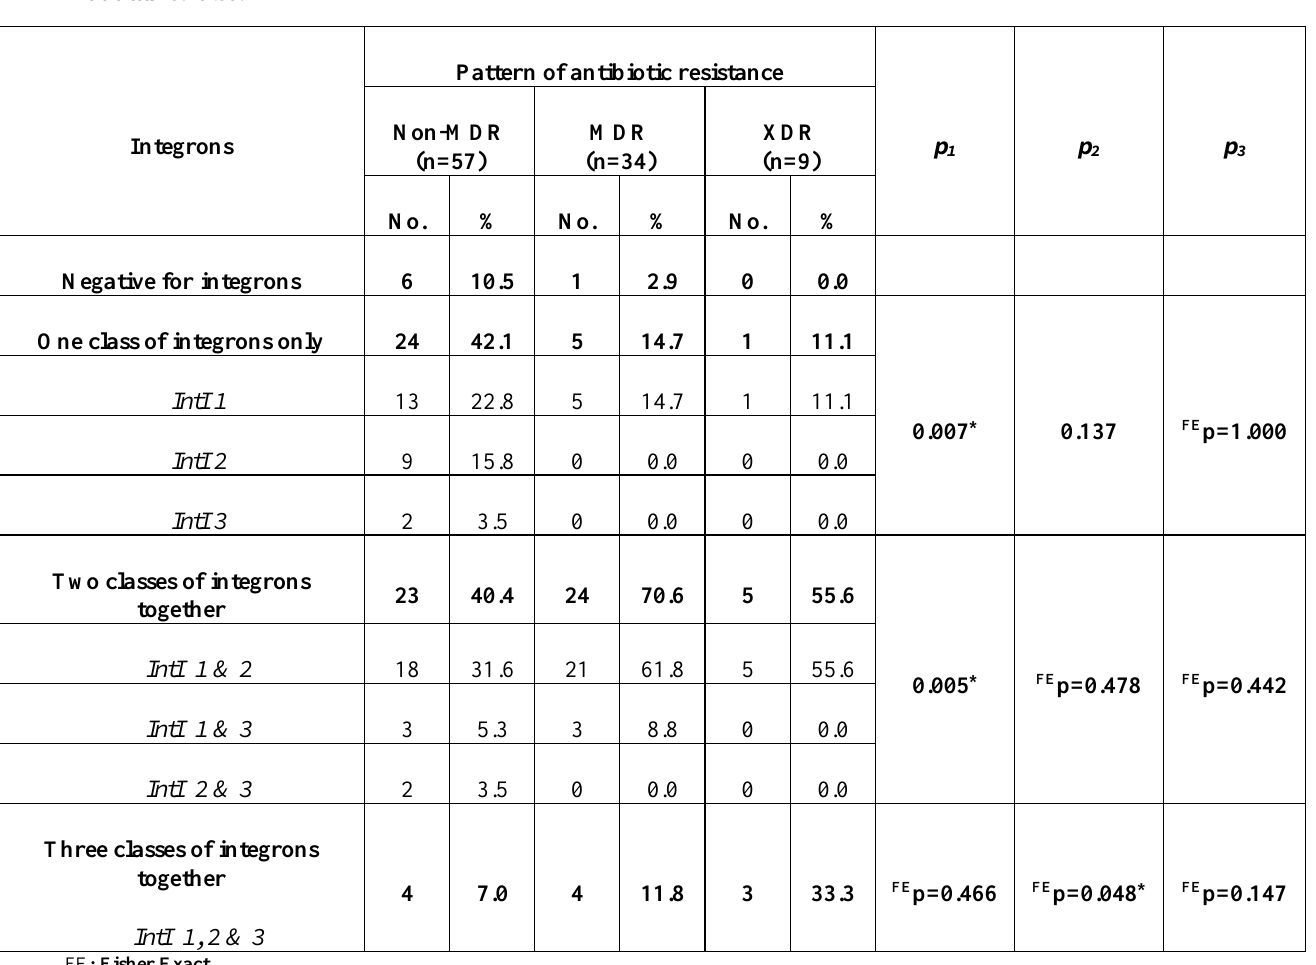
Table 5. Correlation between patterns of antibiotic resistance and presence of integrons among the 100 P. mirabilis